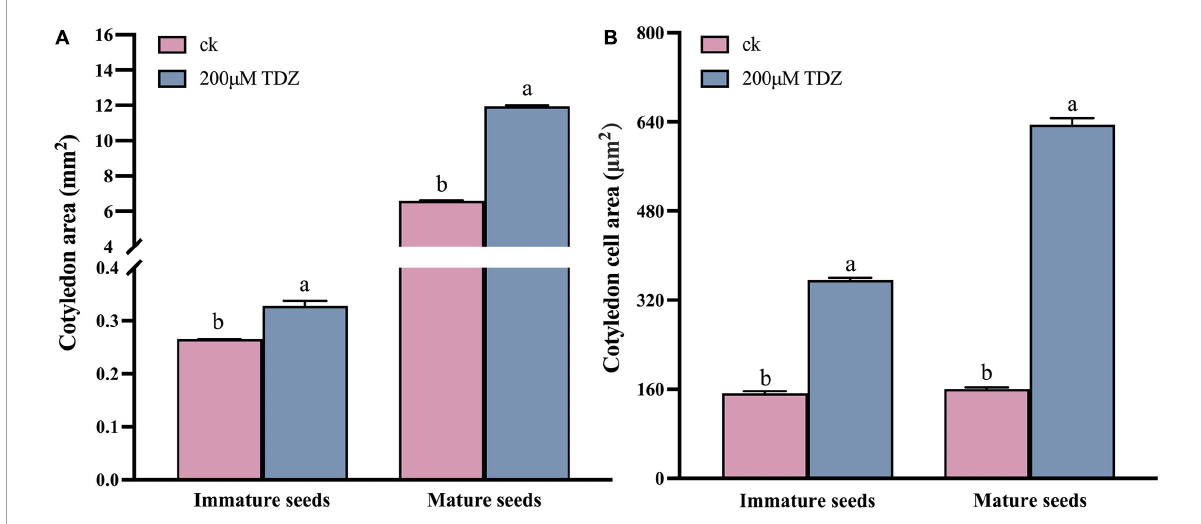
FIGURE4 Cotyledon area (A) and cotyledon cell size (B) of immature seeds and mature seeds. Entire cotyledons from immature embryos and mature dried embryos or their central parts were cleared and photographed. Imaging analysis software was used to calculate areas. Mean ± Standard error ( n = 3). Different values were marked with different letters at 0.05 significance